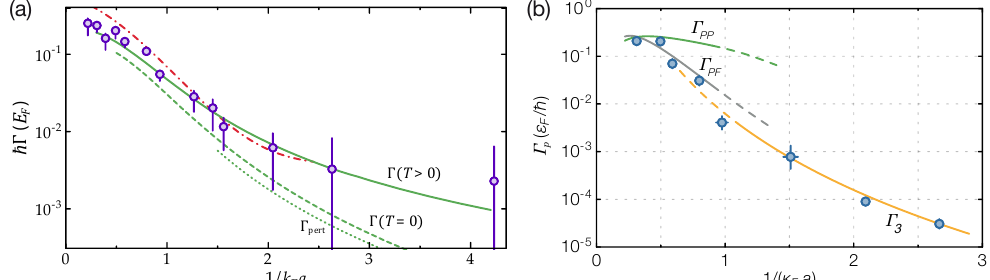
Figure 6. Stability of the repulsive Fermi polaron in the equal-mass, broad-resonance case. ( a ) Deco- herence rate Γ of the repulsive Fermi polaron. ( b ) Population decay rate Γ p of the repulsive branch to lower-lying states. Circles are experimental data points from Ref. [23], obtained by measuring: ( a ) the damping rate of Rabi oscillations on the repulsive polaron, or ( b ) the relaxation of the upper branch measured via a double-pulse experiment. In panel ( a ), lines denote the quasiparticle spectral width Γ calculated with a variational method [28,46,98] at T = 0 (dashed, green) and T = 0.13 E F (solid, green), with functional renormalization group (red, dot-dashed) [83], and at the first non- 4 E F [28] (dotted, green—see Table 2). In panel vanishing order in perturbation theory, Γ pert = 8 ( k F a ) 9 π 3 ( b ), lines denote the upper branch decay rate predicted by considering polaron-to-polaron recom- bination (green) [77], polaron-to-free particle recombination (grey) [23], and three-body molecular recombination (yellow) [105]. Panel ( b ) is adapted from Ref.